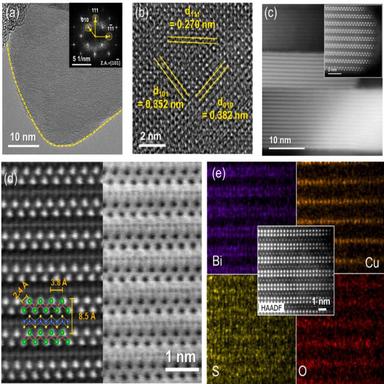
HR-TEM and STEM analysis of BCSO: (a, b) HR-TEM images. Inset shows SAED pattern of a nanosheet (i.e., zone axis ), (c) High magnification and low magnification (inset) STEM image, (d) Atomic resolution HAADF-STEM (left) and ABF-STEM (right) images viewed from zone axis , and (e) EDS mapping (viewed from zone axis at scale of 1 nm).